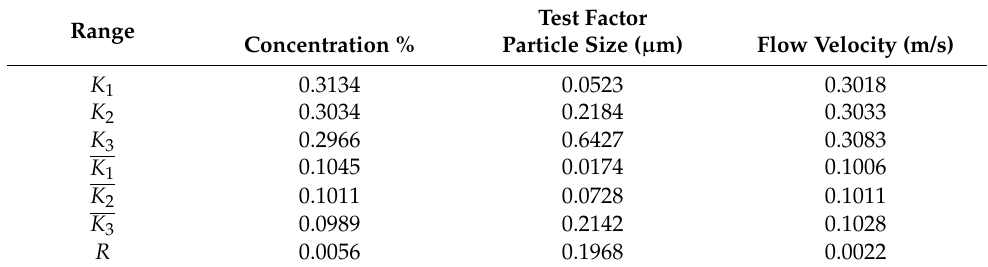
Table 9. Degree of influence of each factor on the sedimentation velocity.